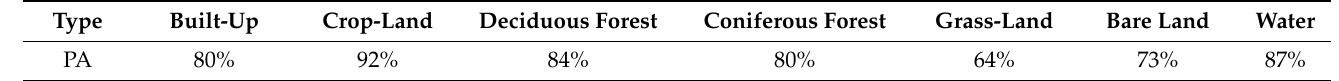
Table 4. Average producer’s accuracy (PA) of the LC classifications per category.